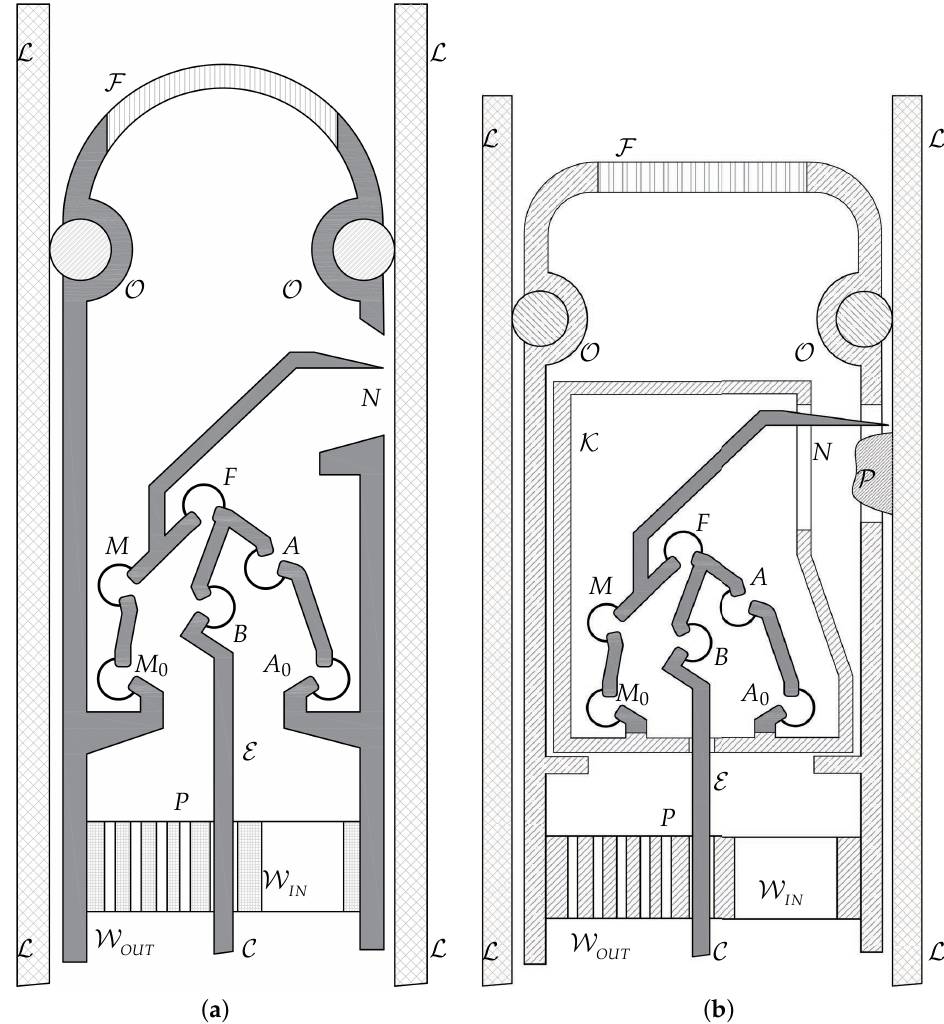
Figure 4. A view of the endoluminal microsystem designed for future validation at TRL 4 ( a ) and TRL 5 with the packaging K ( b